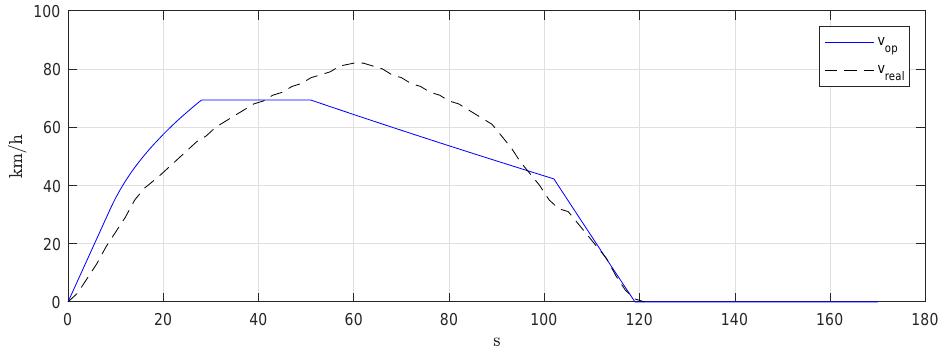
Figure 10. Case A—Actual (dashed black) and proposed (solid blue) speed profiles.